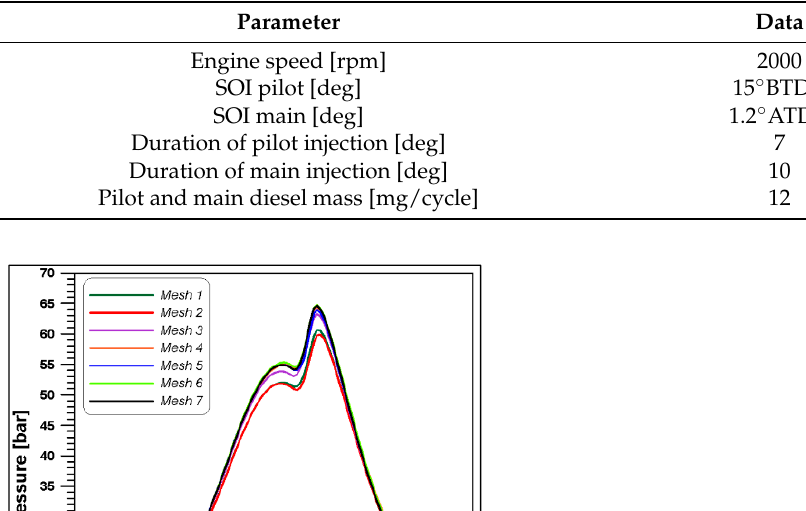
Table 7. Simulation settings for the full diesel simulations.